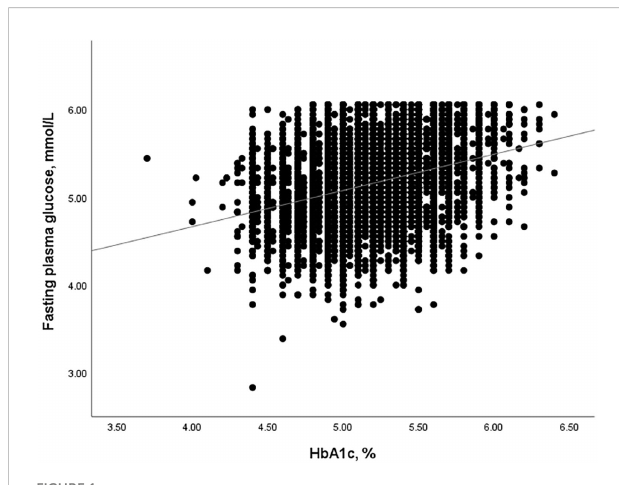
FIGURE 1 The correlation between HbA1c and HGI levels.